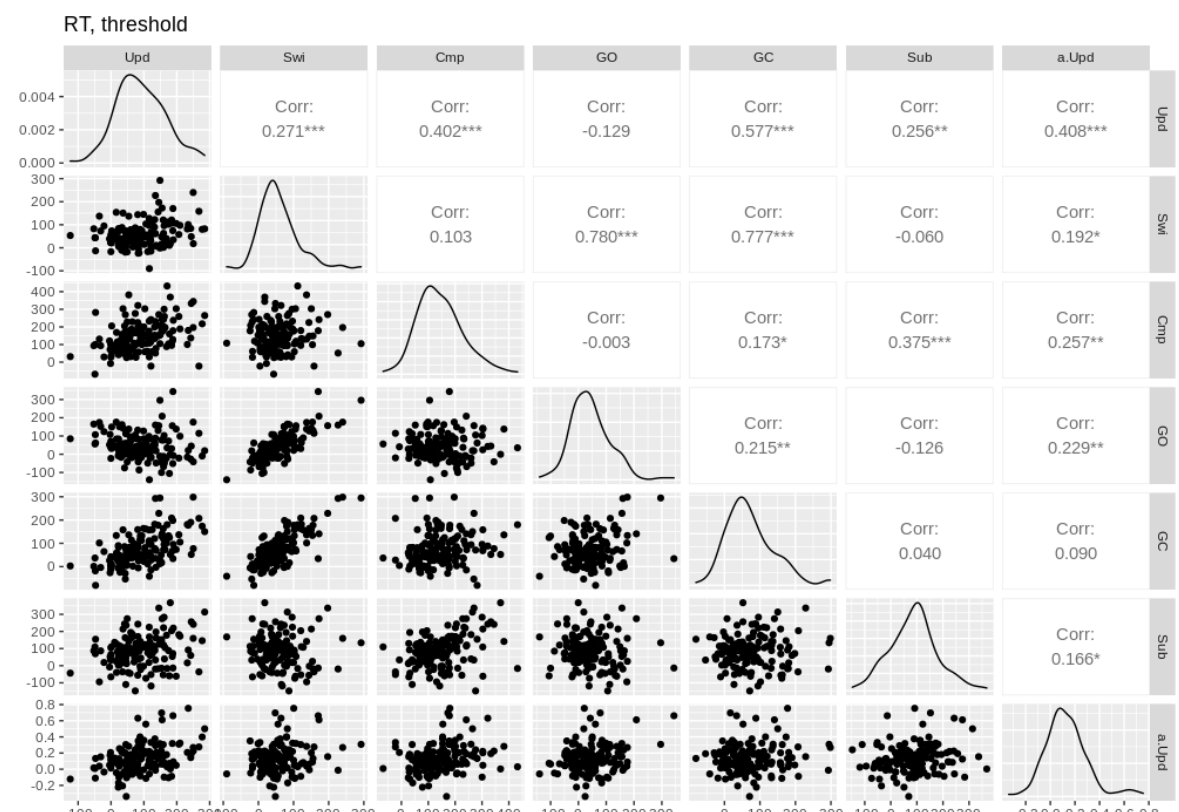
Figure A7. Pairwise Pearson correlations between threshold and RT cost effects. Empirical effects are shown in the first six columns. Parameter effects are shown in the last column (prefixed with the parameter name). Upd = updating, Swi = switching, Cmp = comparison, GO = gate opening, GC = gate closing, Sub = substitution. Asterisks *, **, and *** denote p ‐ values of <0.05, <0.01, and <0.001, respectively.